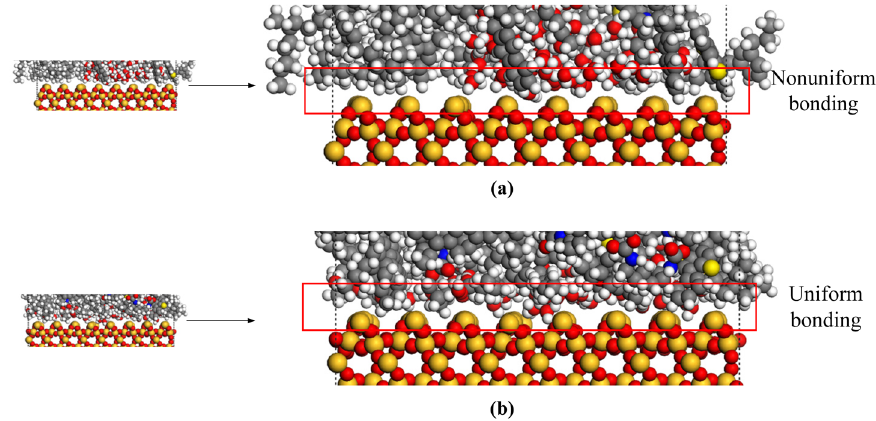
Figure 15: Contact surface between di ff erent asphalt and aggregate: ( a ) original asphalt – aggregate and ( b ) PU - modi fi ed asphalt –